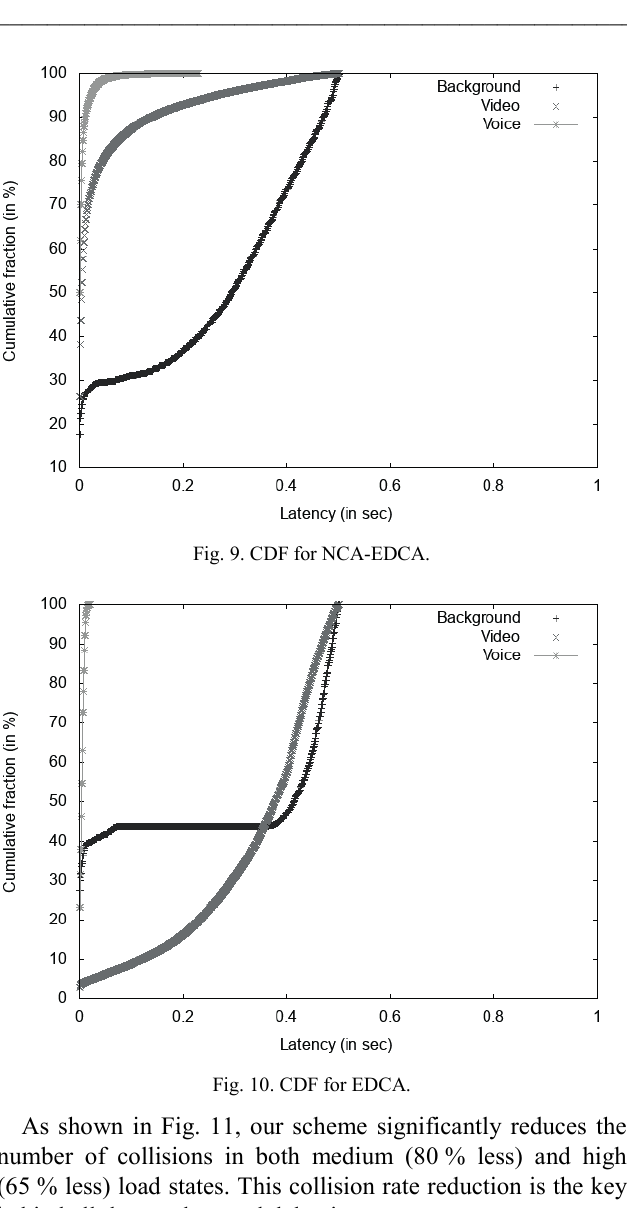
Fig. 12. Fairness of NCA-EDCA.